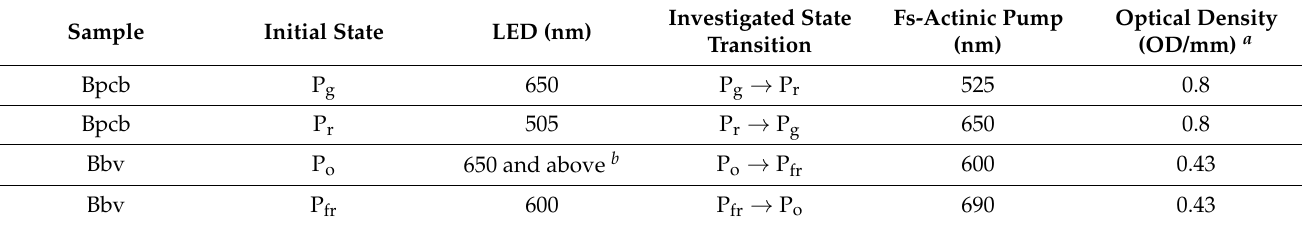
Table 1. Laser and LED irradiation conditions for the CBCR reversible photoswitching